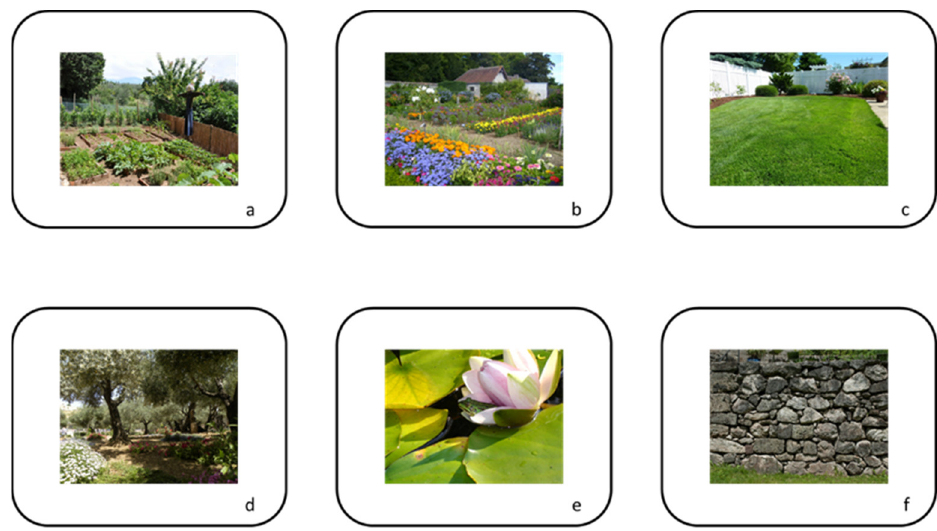
Figure 3. Home garden most usual “spaces”: ( a ) the vegetable garden; ( b ) the flower garden; ( c ) the lawn; ( d ) trees, shrubs, and hedges; ( e ) the garden pond; ( f ) paved and constructed surfaces.